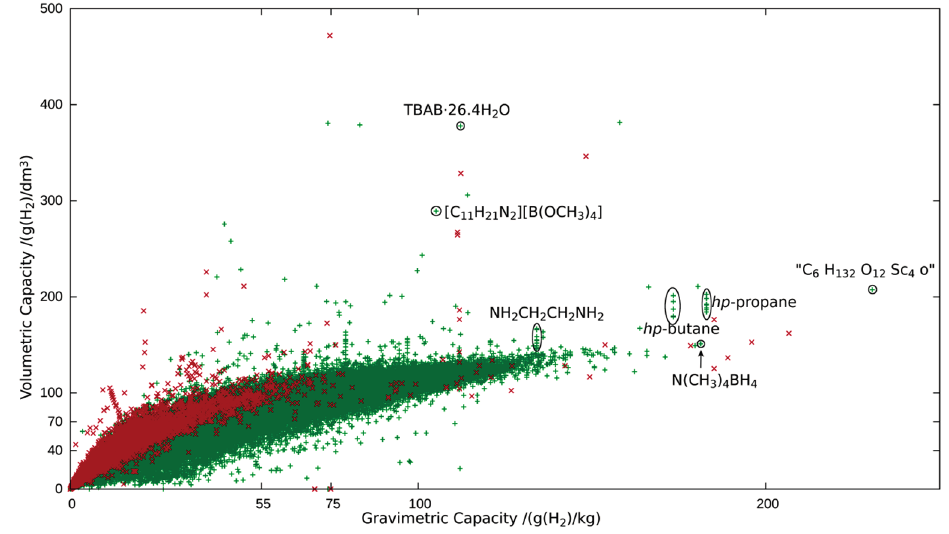
Figure 3. Plot of all hydrogen-containing organic (green plusses) and inorganic compounds (red crosses) in the COD in terms of volumetric and gravimetric hydrogen density. Some specific examples are labelled in the